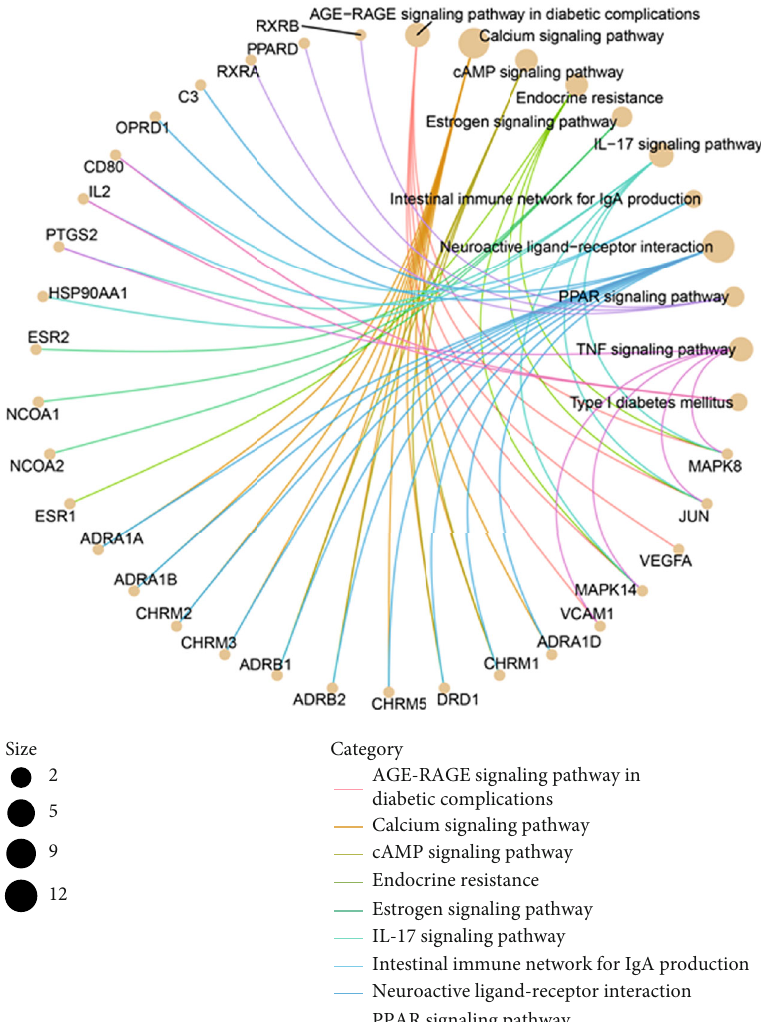
Figure 6: The potential key signaling pathways and involved genes of TwHF for treating